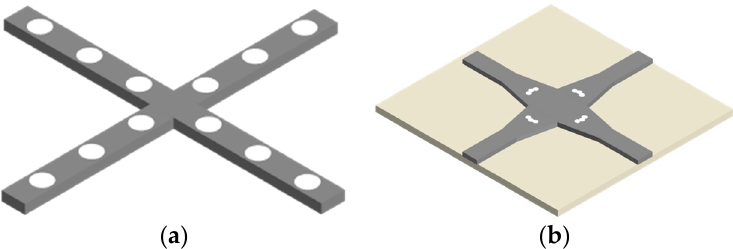
Figure 5. ( a ) Schematic of the inverse-designed silicon waveguide crossing and ( b ) top view of the ultra-compact silicon waveguide crossing with holey SWG grating method .